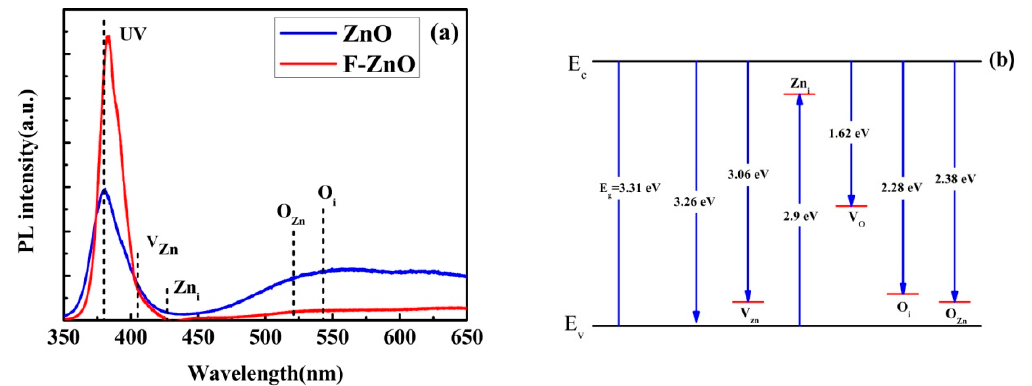
Figure 4. ( a ) The photoluminescence (PL) of ZnO films with and without SF 6 plasma treatment and ( b ) the energy level diagram of ZnO.